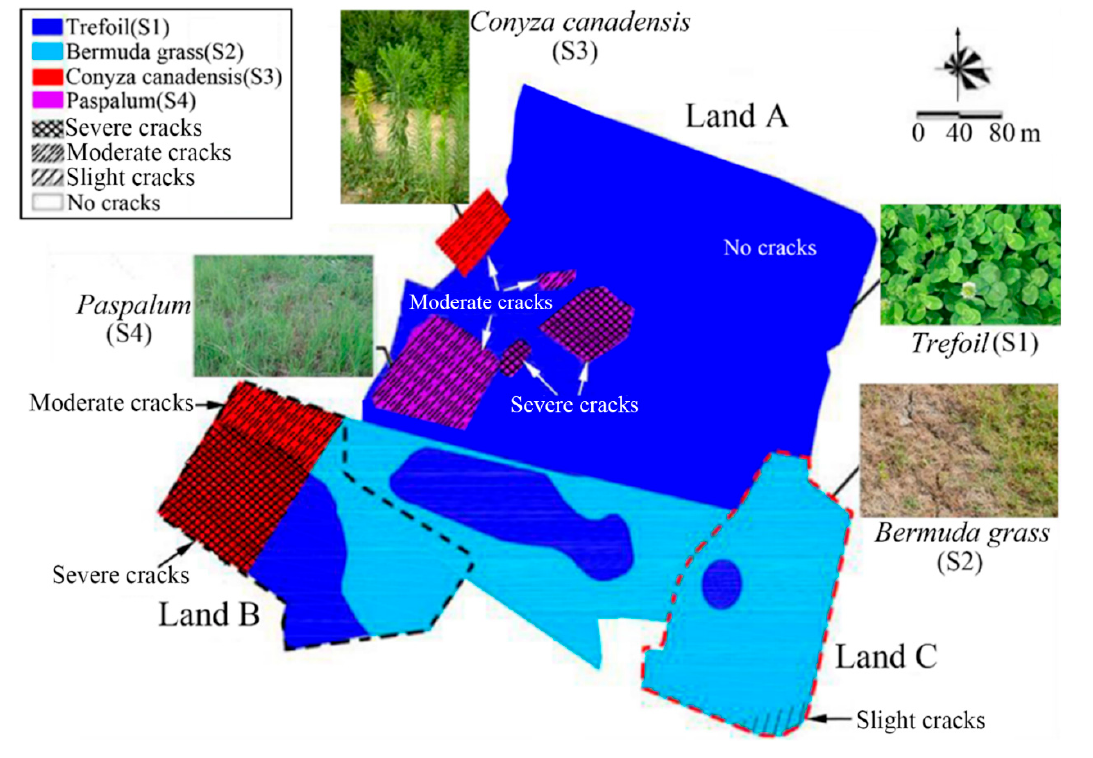
Figure 8. The schematic effects of plant distribution on crack distribution: the relationship between the crack degree and plant distribution.